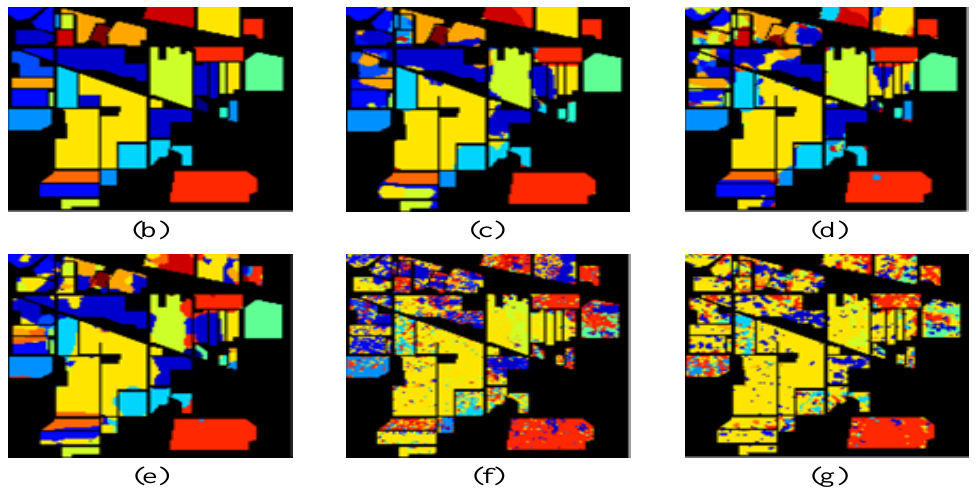
Figure 7. ( a ) False-color composite (R: 26, G: 14, B: 8), ( b ) ground truth, ( c ) SS-3DCNN